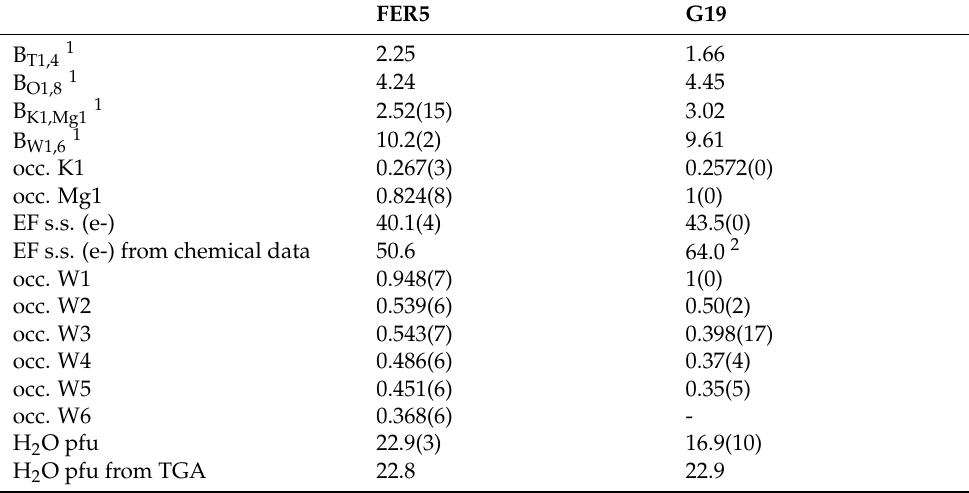
Table 5. Average isotropic displacement parameters (Å2) and extra-framework cation and H 2 O molecule sites population. Isotropic displacement parameters of H 2 O molecule sites were kept fixed throughout the refinements. Data of ferrierite (G19) from Giacobbe et al. [22] are reported for